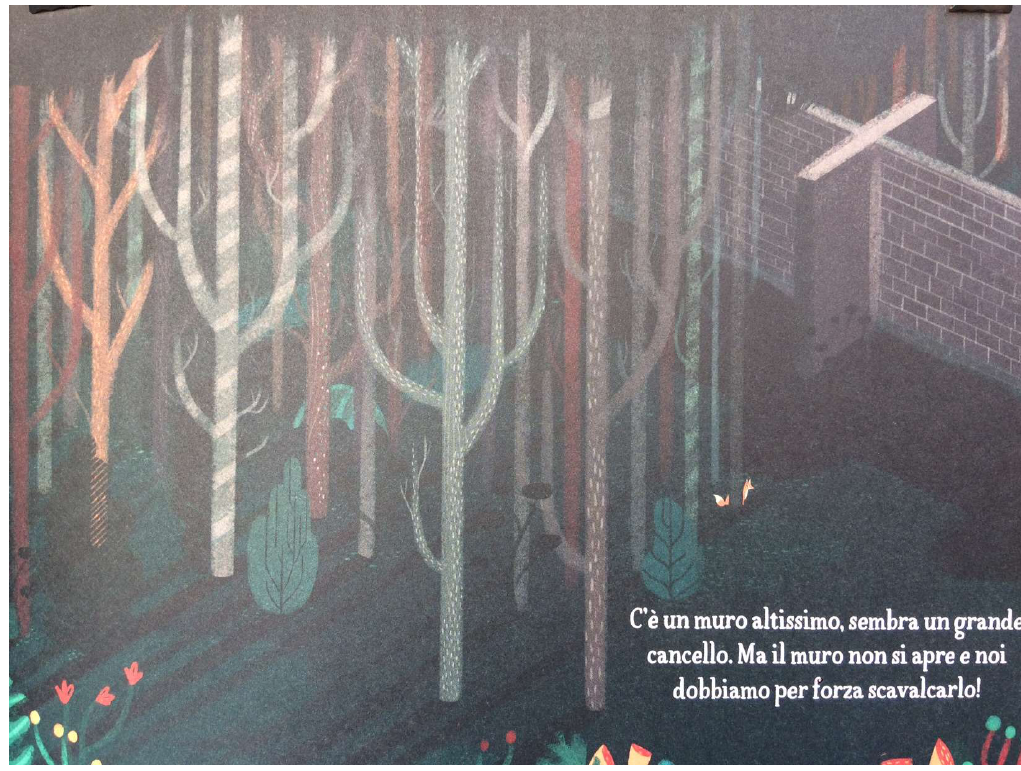
Figure 6. The wall, from: Il Viaggio , cit. p.